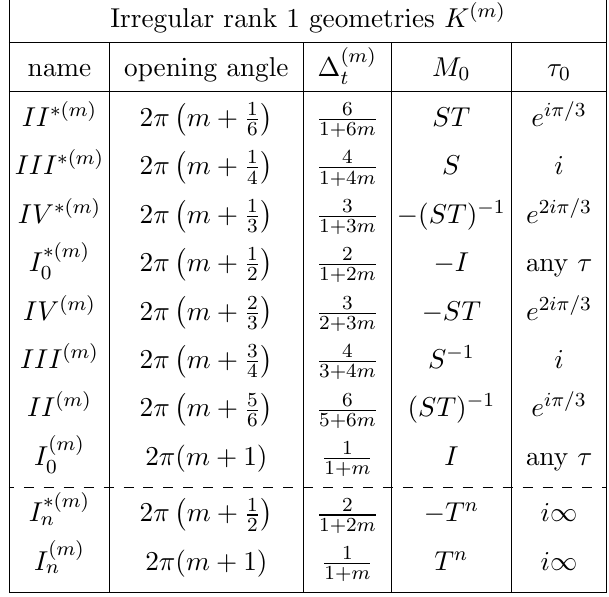
Table 3. All geometries of 1-dimensional special Kahler cones. m (cid:21) 0 is a non-negative integer, and n > 0 is a positive integer. For m = 0 we reproduce the standard Kodaira classi(cid:12)cation, if m > 0 we instead obtain the irregular geometries. Shown are the allowed values of the opening angle of the cone, of the scaling dimension of the uniformizing parameter (cid:1) ( m ) monodromy conjugacy class about the tip of the cone M 0 , and of the value of the complex modulus of the (cid:12)ber at the tip (cid:28) 0